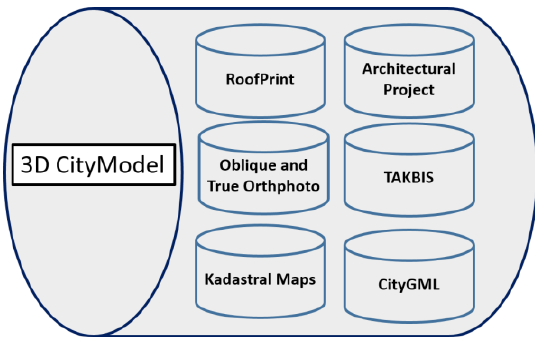
Figure 5. Contents of 3D City Model